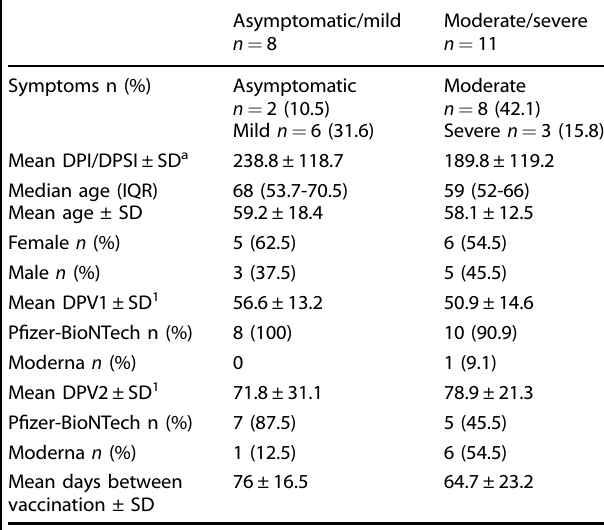
Fig. 4 Assessment of antibody-dependent activation of cell-mediated cytotoxicity by plasma collected post infection. a MRC-5 cells were gated on forward and side scatter characteristics to illustrate expression of Wuhan-Hu-1 S on non-transduced (white histogram, 0%) and spike-transduced (gray histogram, 92%) MRC-5 cells in a representative histogram. Background NK cell-mediated lysis of b non-transduced (white bar) or S-expressing (grey bar) MRC-5 cells mediated either by plasma Ab from SARS-CoV-2-seropositive or seronegative (pre pandemic) individuals, respectively, was measured. Bars represent the mean of individual plasma samples (circles) with standard deviation depicted in red. Natural killer cell-mediated lysis of S-expressing MRC-5 cells enabled by Ab generated after infection was measured by 51 Cr release (E:T 25:1) and correlation with c DPI/DPSO and d symptom severity assessed. COVID-19 symptom severity: asymptomatic = 0; mild = 1; moderate = 2; severe = 3. ADCC experiments were performed with three independent PBMC donors and representative plots shown. Table 2. Relevant features of functionally studied